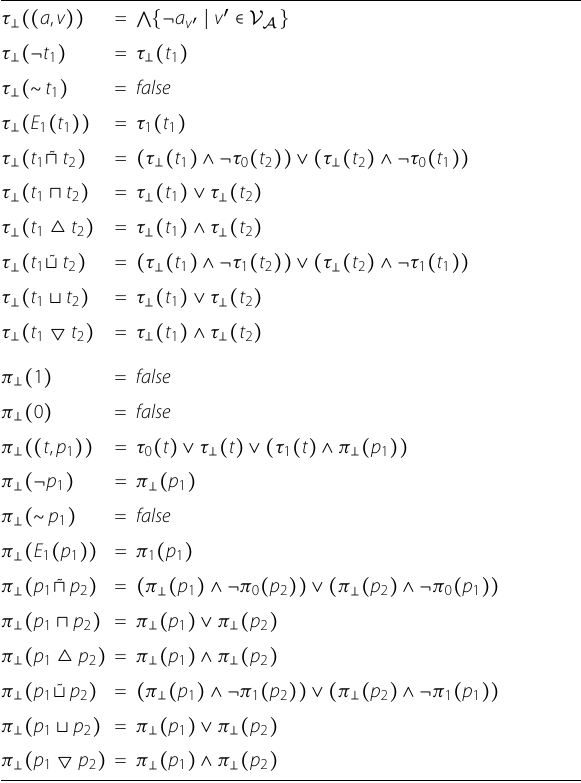
Table 4 Transformation rules for τ (for targets) and π (for policies) for decision (cid:6)